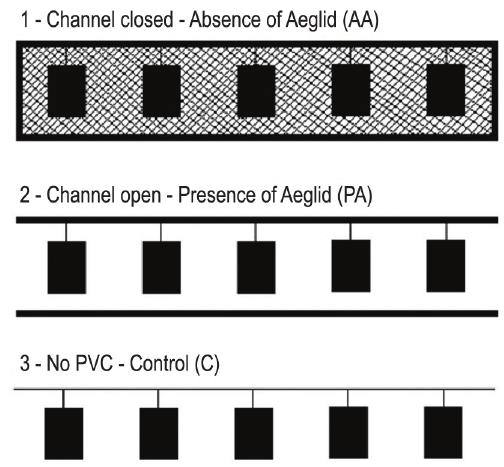
Figure 1. Experimental design, indicating the different types of treatment used in the study. The solid rectan- gles indicate the litter bags, the thick bars indicate the channel